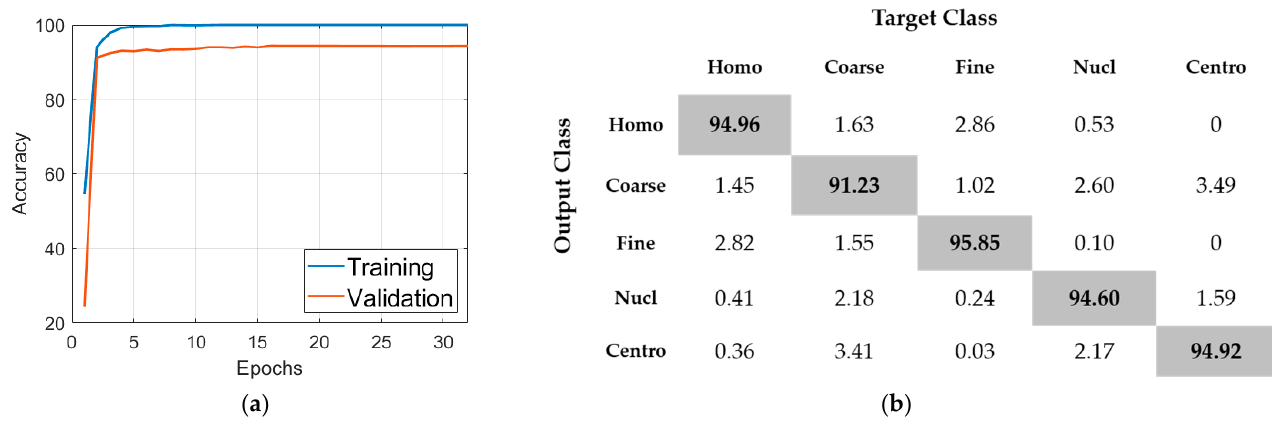
Figure 10. Results of the initial learning process: ( a ) the progression of the accuracy of training and validation; ( b ) the confusion matrix (total accuracy of 94.31%). “Homo”, “Coarse”, “Fine”, Nucl” and “Centro” stand for homogeneous, coarse speckled, fine speckled, nucleolar and centromere, respectively.